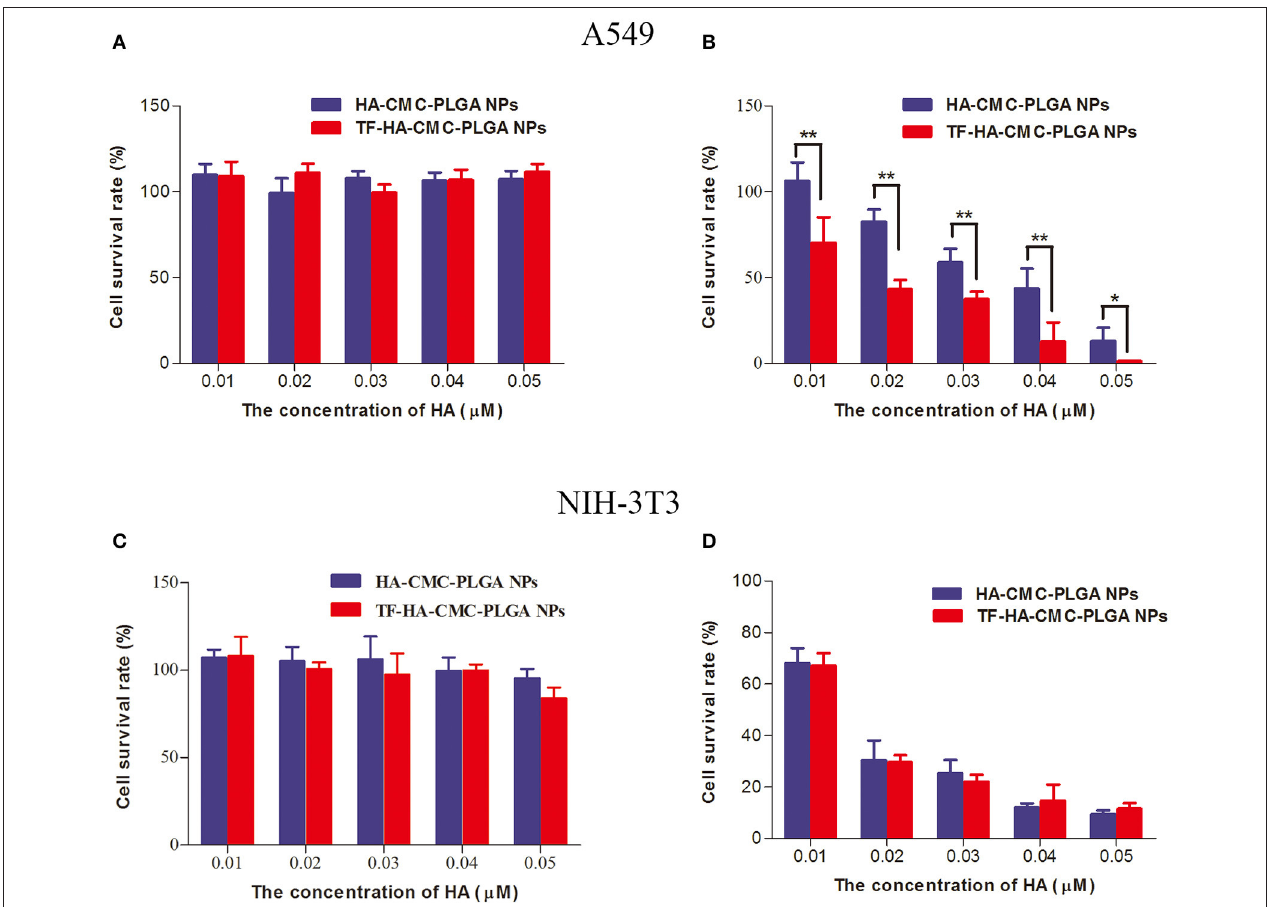
FIGURE 5 | Dark cytotoxicity (A) and photo-cytotoxicity (B) assays of HA-CMC-PLGA NPs and TF-HA-CMC-PLGA NPs on A549 cells; Dark cytotoxicity (C) and photo-cytotoxicity (D) assays of HA-CMC-PLGA NPs and TF-HA-CMC-PLGA NPs on NIH-3T3 cells. The cells were exposed to 470nm LED (90 mW/cm2) for 15min in (B,D) . Each data point (mean ± SD) was calculated for quintuplicate (n = 5). * p < 0.05; ** p <